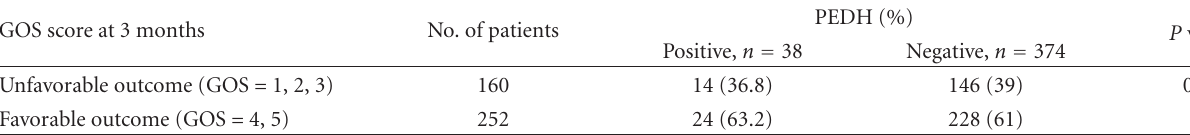
Table 1: Association between PEDH and Glasgow Outcome Scale scores.